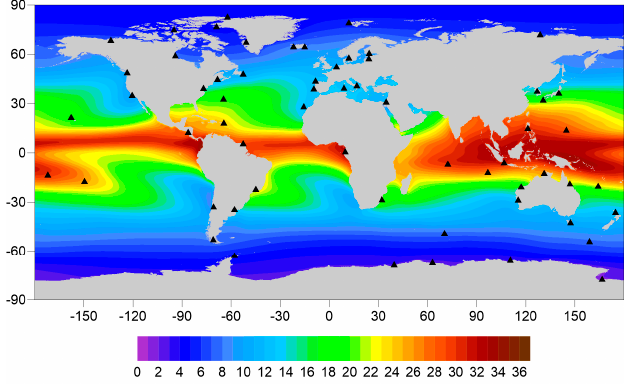
Figure 1. Location of a set of 60 Global Navigation Satellite System (GNSS) stations used in this study (adapted from [43]). The background map represents the Root Mean Square (RMS) of wet path delay (WPD) in cm.